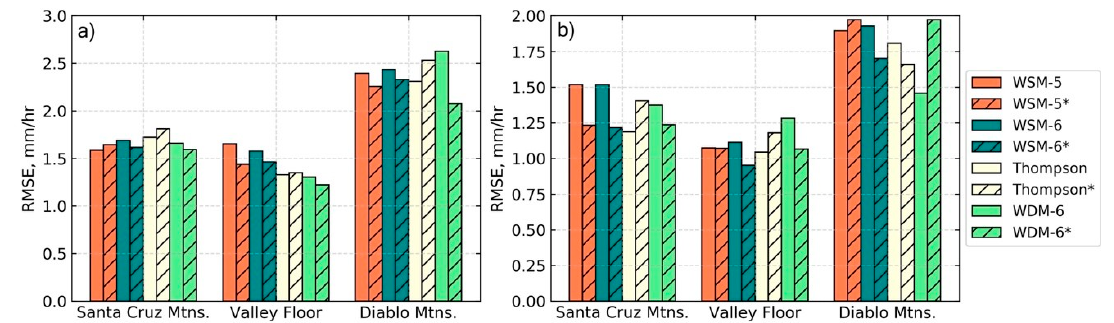
Figure 10. Hourly precipitation rate root-mean-squared-error for ( a ) AR1 and ( b ) AR2. * denotes 1/3 km resolution.